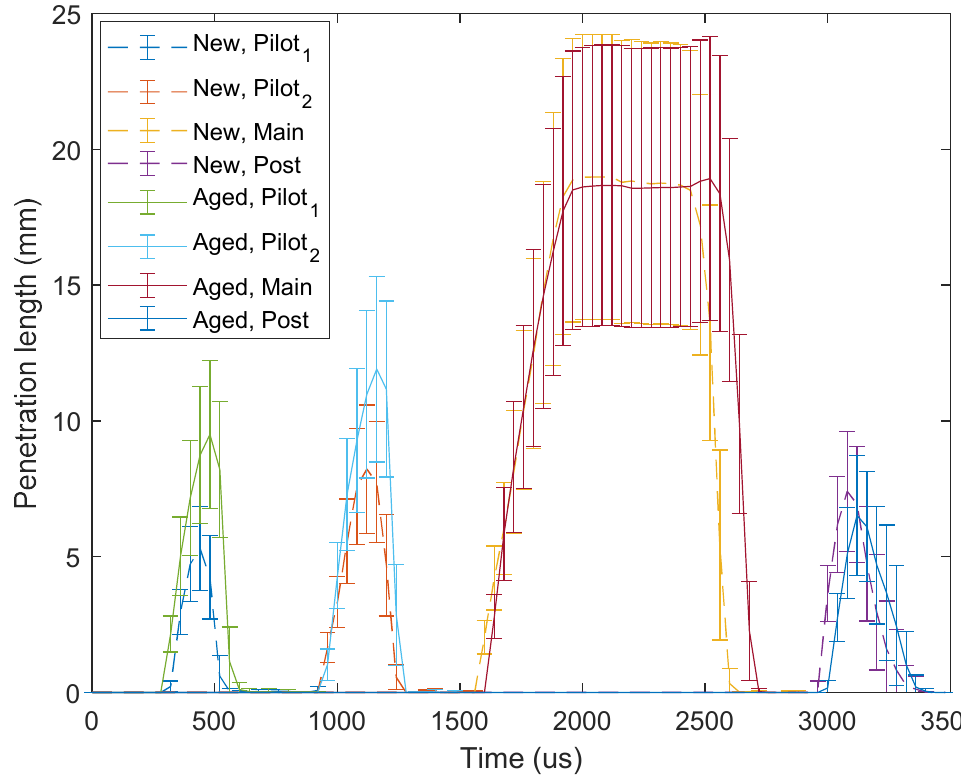
Figure 12. Spray penetration at medium load using new and aged injectors.